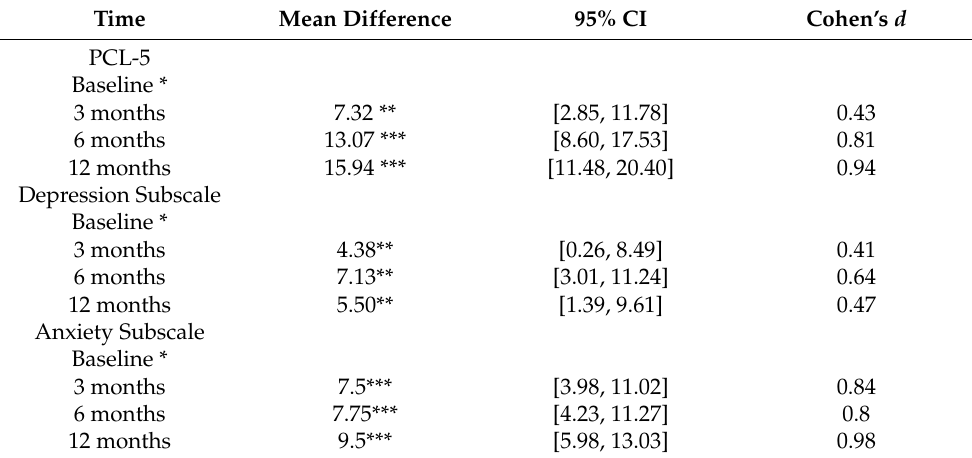
Table 4. Planned Comparisons for Mean Difference and Effect Size between Baseline and 3, 6, and 12 Months on PCL-5 and DASS-21 Depression and Anxiety